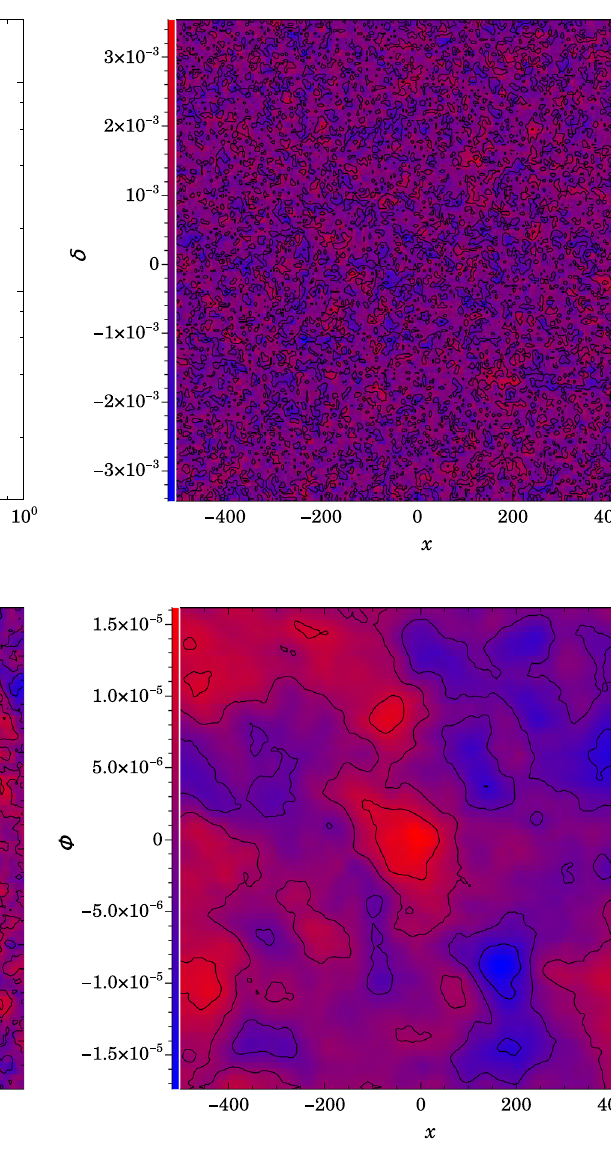
Fig. 1 Matter power spectrum and the initial conditions derived from it. There are four curves in the first plot: the black one is the mat- ter power spectrum at z + 1 = 1090 produced by CAMB [38] with parameters listed in Table 1; the red, blue and cyan curves are the matter power spectra drawn from density perturbations δ( x i ) by the function power_spectrum_1d in c2raytools [37] at 160 3 , 80 3 and